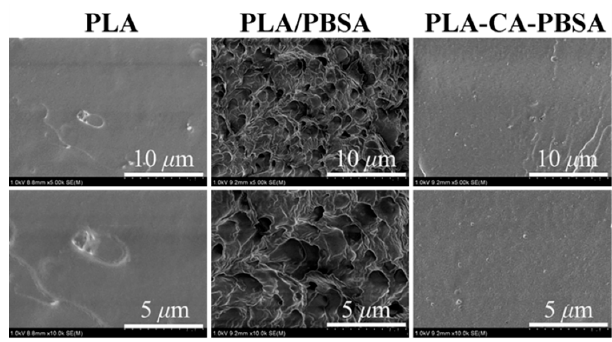
Figure 6. SEM micrographs of fractured surfaces of PLA, PLA/PBSA and PLA-CA-PBSA.